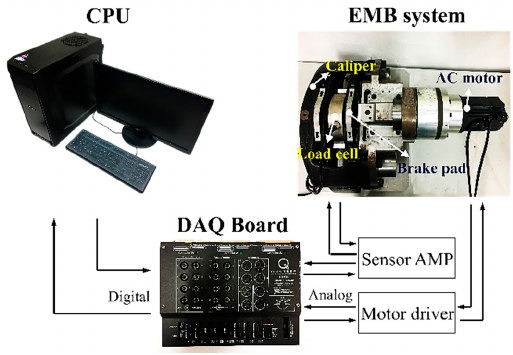
Figure 11. Configuration of experimental setup.